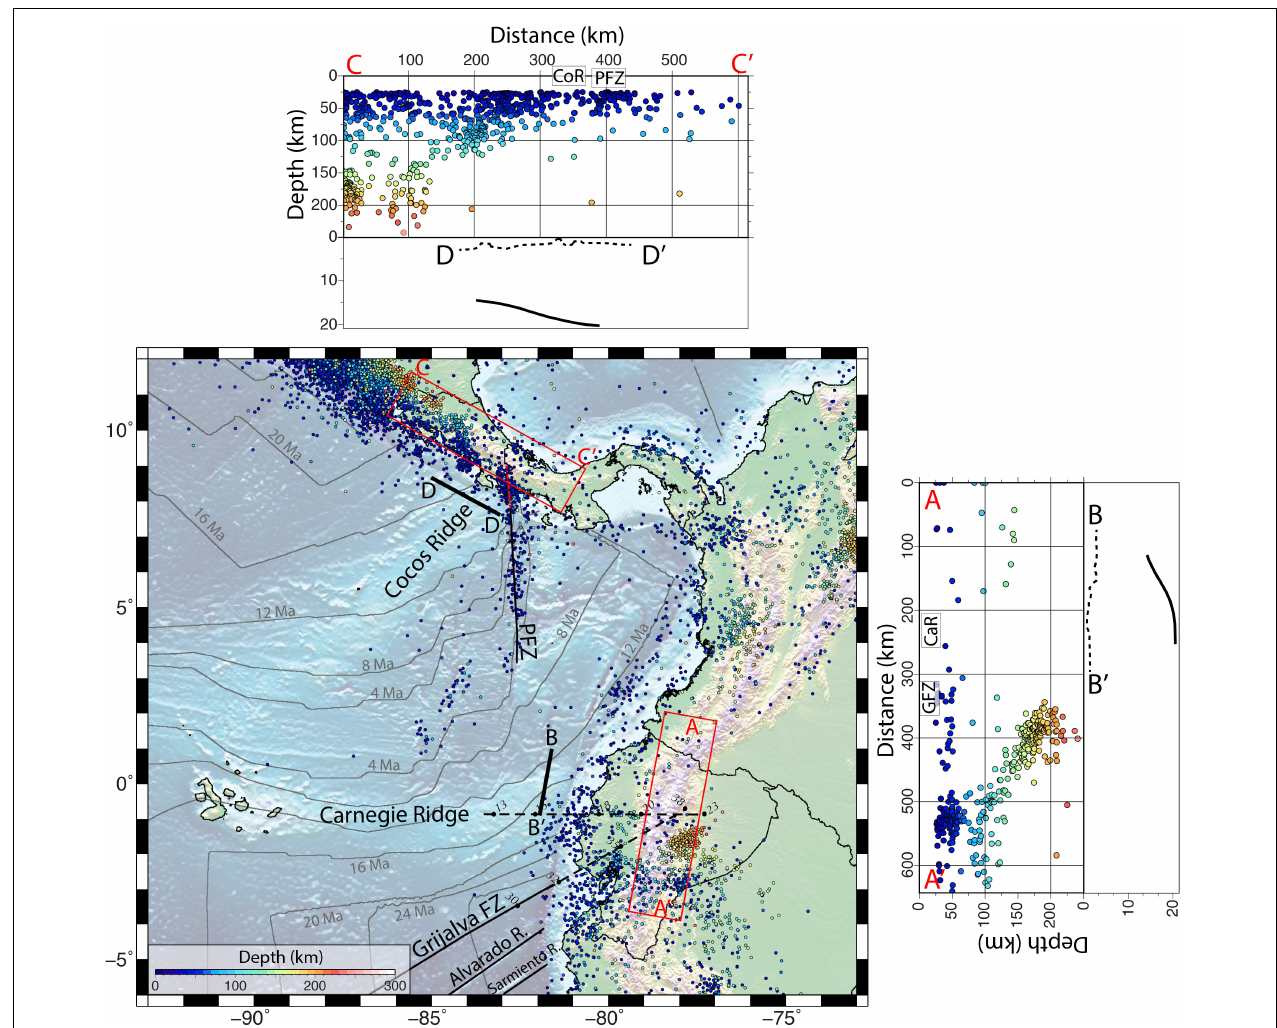
FIGURE 4 | Carnegie and Cocos Ridge subduction and earthquake distribution. Left: Map showing seismicity from the Reviewed International Seismological Center’s earthquake catalog (1990–2017) as small circles. Offshore gray lines show age contours from Mueller et al. (2008). Offshore solid black line across the Carnegie Ridge shows the location panel B,B (cid:48) of the cross section from Sallares et al. (2005). Offshore solid black line across the Cocos Ridge shows the location panel D,D (cid:48) of the cross section from Sallares et al. (2003). Black dashed lines and italic numbers show the projected Carnegie Ridge and Grijalva Fracture Zone locations and ages from Lonsdale (2005). Dash-dot red line shows projected location of the Panama Fracture Zone. Red rectangular box panel A,A (cid:48) shows area over which events were projected onto cross section to the right. Right: Cross-section panel A,A (cid:48) across the projected location of the subducted Carnegie Ridge. Circles show projected event locations (depth in km) from the Reviewed ISC catalog (1990–2017). Left panel (B,B (cid:48) ) shows depth below sea level in km for the oceanic Moho (solid black line) and bathymetry (dotted line) across the Carnegie ridge from Sallares et al. (2005). Top: Cross-section panel C,C (cid:48) across the projected location of the subducted Cocos Ridge. Circles show projected event locations (depth in km) from the Reviewed ISC catalog (1990–2017). Lower panel (D,D (cid:48) ) shows depth below sea level in km for the oceanic Moho (solid black line) and bathymetry (dotted line) across the Carnegie ridge from Sallares et al.